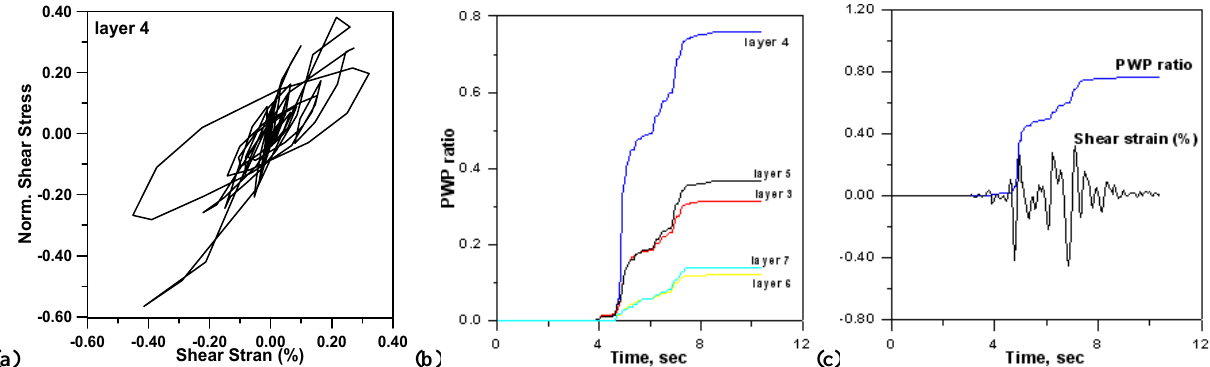
Figure 16 Fig. 16. Stress-strain history (a) for the layer with high probability to liquefy; PWP time histories at different ground level (b) ; PWP and shear strain time histories (c) for the layer with high probability to liquefy.